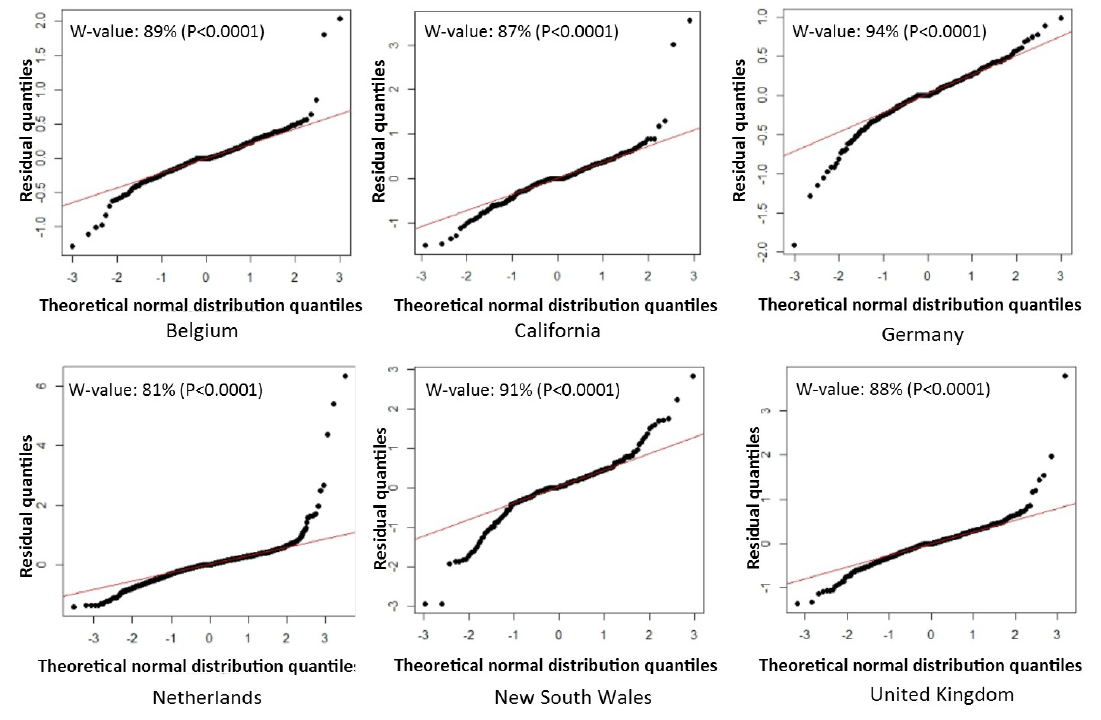
Figure A1. The Q-Q plots of residuals of countries and regions in Table 3 for non-shading group. W-value: The percentage number from Shapiro-Wilk’s W test. P: p value reports the statistical significance of the